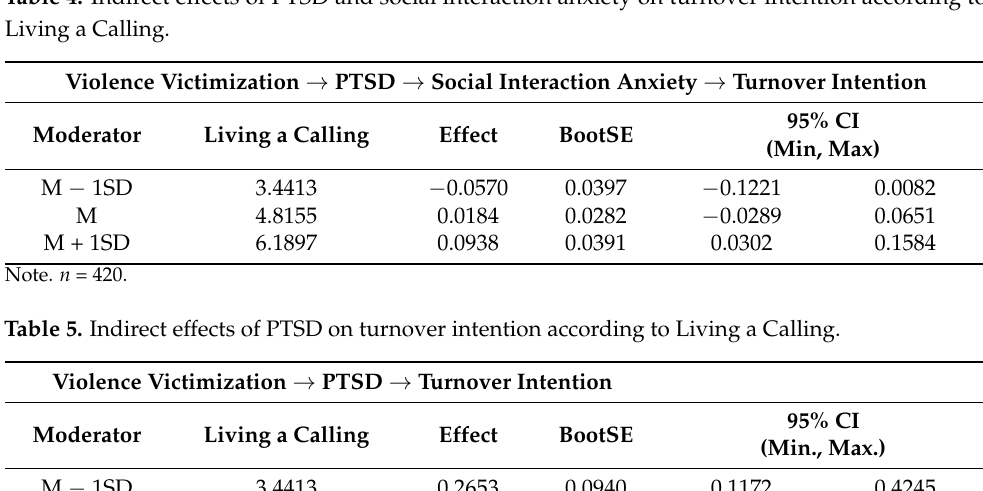
Table 4. Indirect effects of PTSD and social interaction anxiety on turnover intention according to Living a Calling.